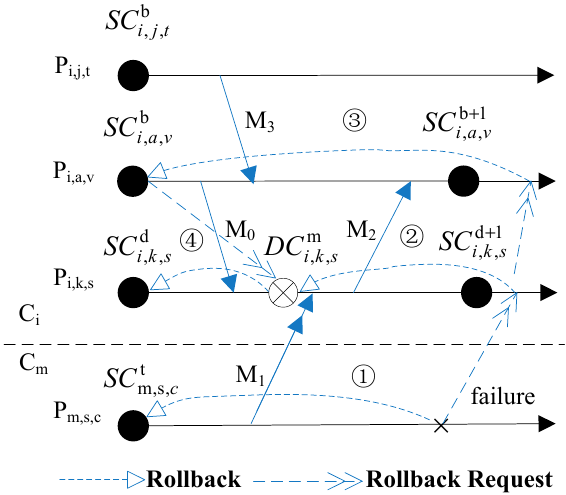
Figure 3. Example of checkpoints dependence.